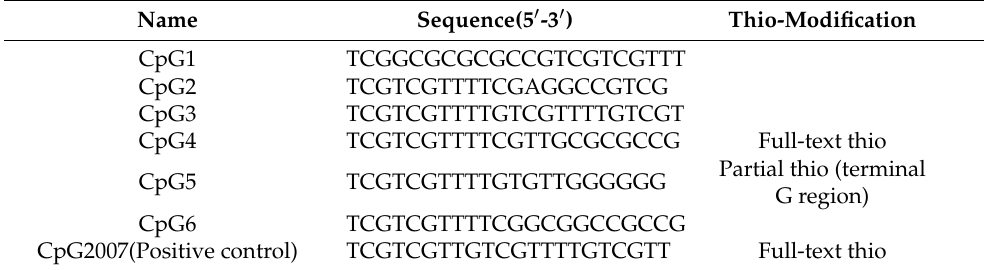
Table 1. Sequences of CpG